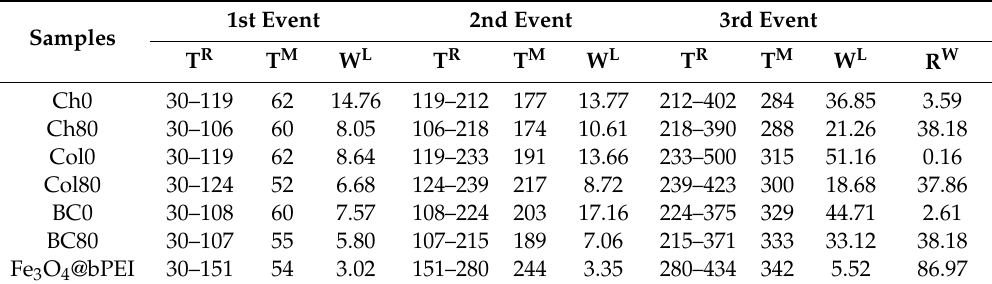
Figure 5. Decomposition curves of pure biopolymers film-form, composite films with 80% of SPIONs and Fe 3 O 4 @bPEI NPs: ( a ) thermogravimetric analysis (TGA) and ( b ) derivative thermogravimetry (DTG) curves. Table 2. Degradation events for pure biopolymers film-form, composite films with 80% of SPIONs and Fe 3 O 4 @bPEI (SPIONs).